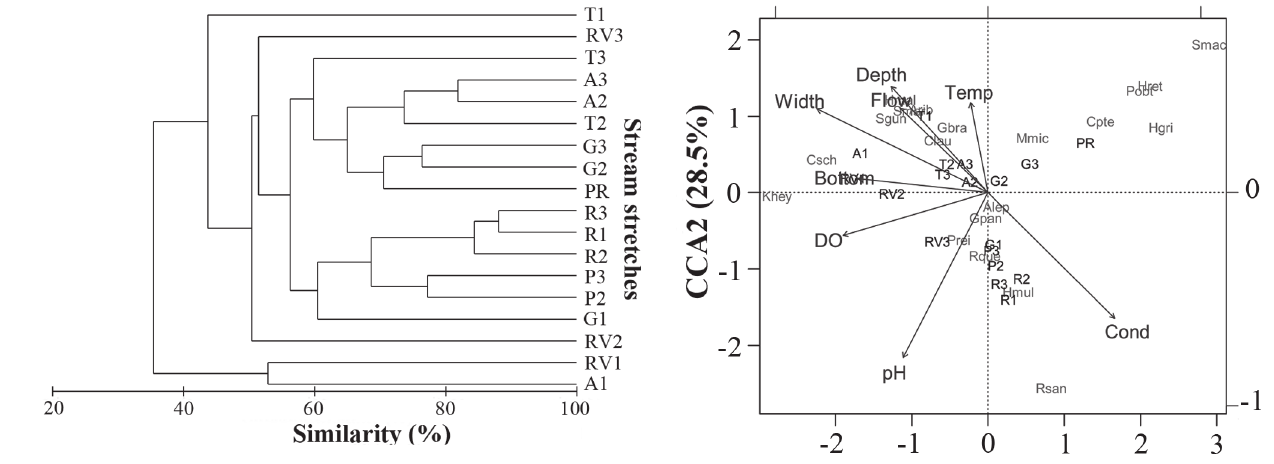
Fig. 3. Dendrogram of similarity produced by cluster analysis, according to ichthyofauna abundance data in each site of Jureia-Itatins Ecological Station. Streams: Antas (A), Tetequera (T), Grajaúna (G), “Ponte 2” (P), rio Verde (RV), “Riacho 1” (R), and rio Preto (PR). Stretches: upper (1), middle (2), and lower (3).